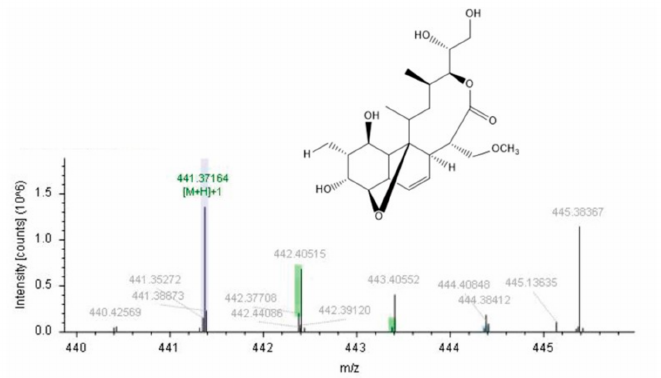
Figure 6. HRLMS spectrum of fraction A13B12, C 23 H 36 O 8 , [M+H] + = m/z